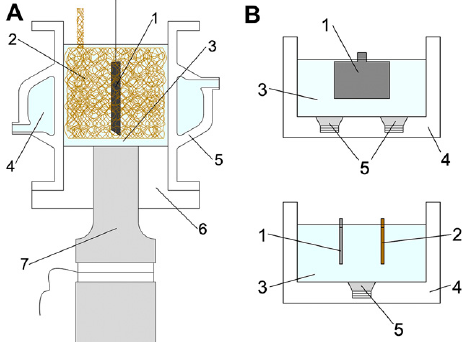
Figure 4. ( A ) 20 kHz sonoreactor adapted as a sonoelectrochemical device: (1) lead dioxide electrode,